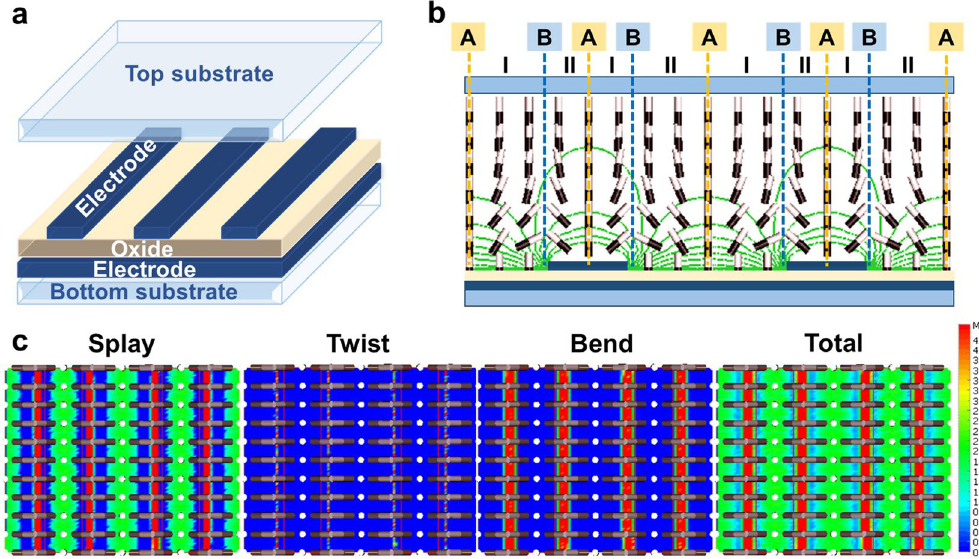
Figure 1. ( a ) Structure of an LC cell with double-layered electrodes. ( b ) LC director orientation and equipotential lines in a VA cell driven by an in-plane electric field. ( c ) Splay, twist, bend, and total elastic energy profiles in a VA cell driven by an in-plane electric